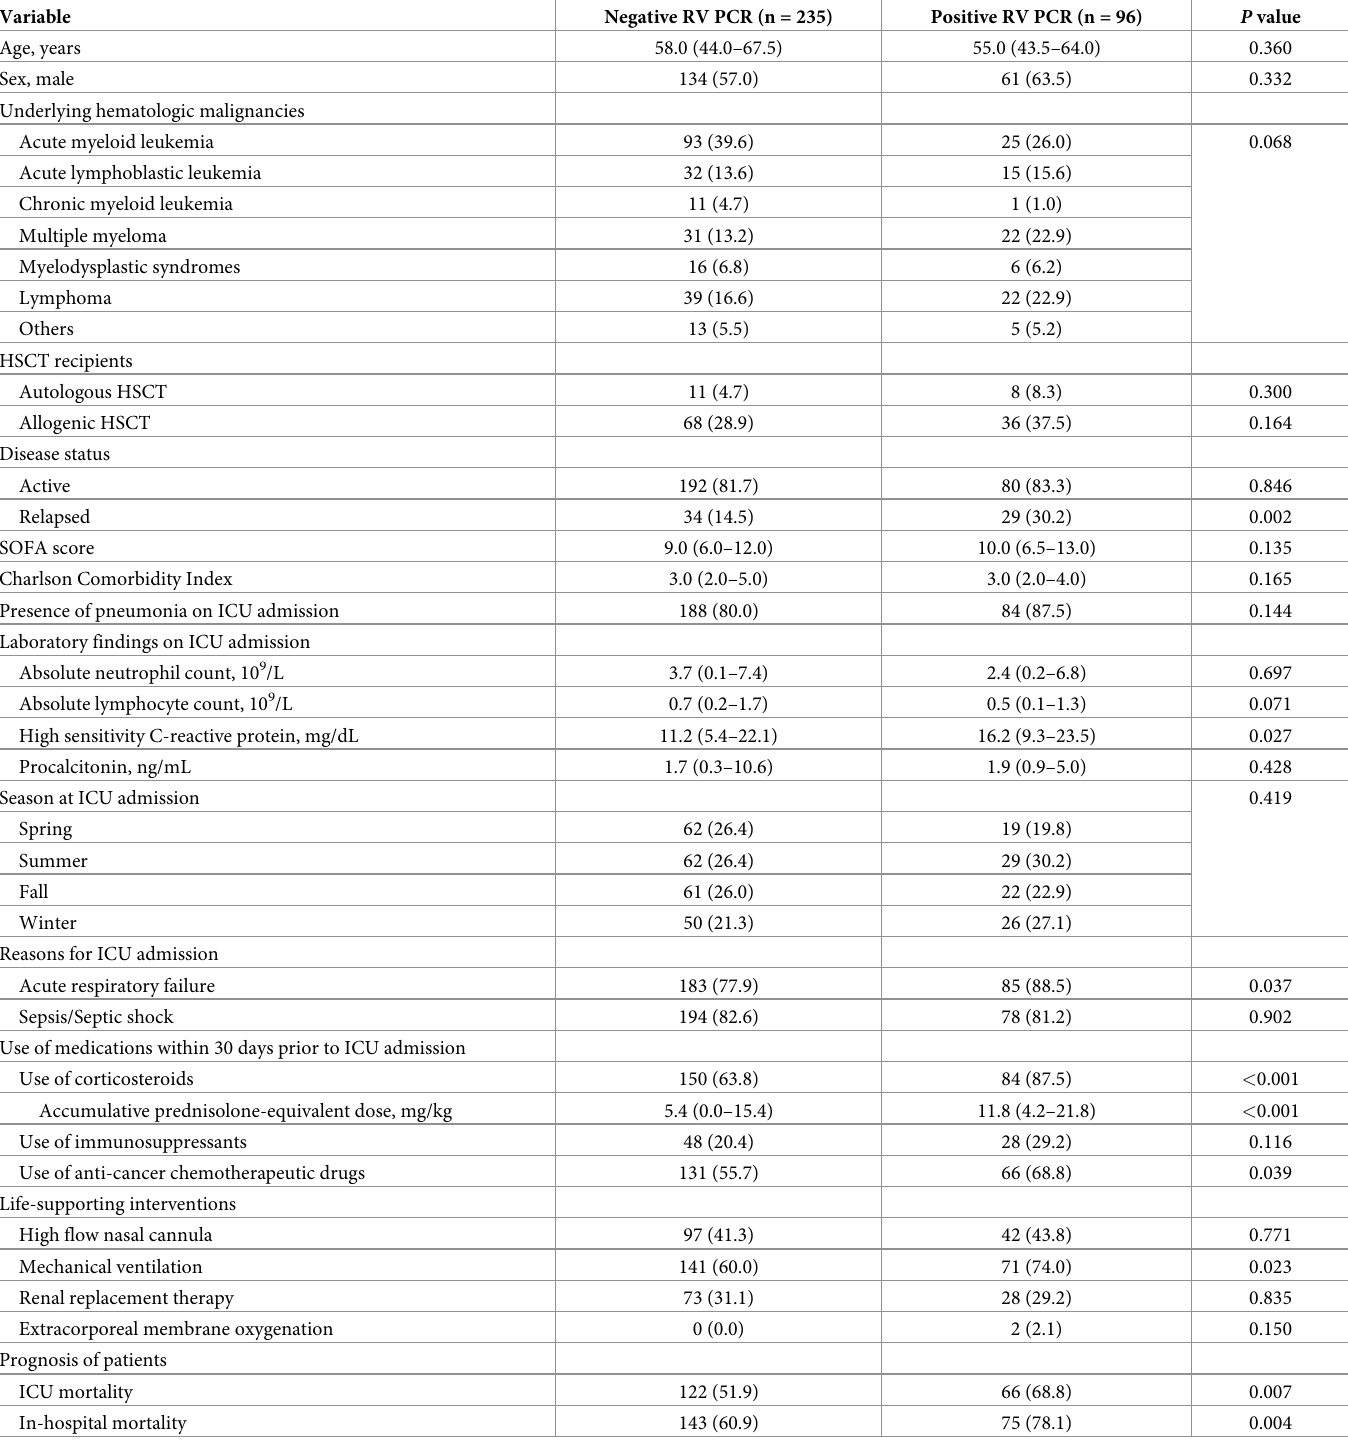
Table 2. Comparison of clinical characteristics of patients with negative and positive upper airway respiratory virus